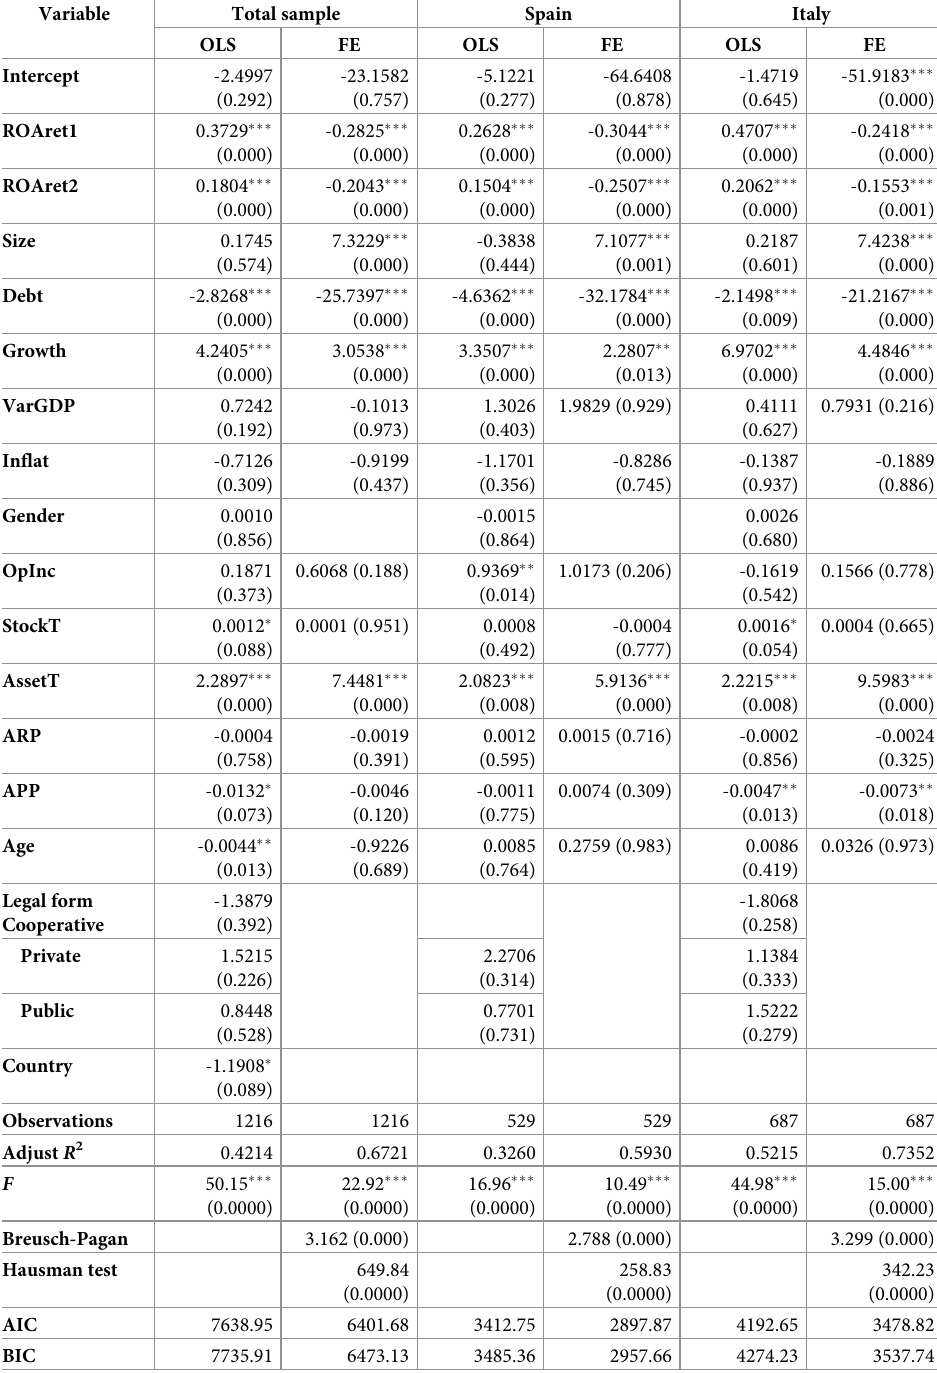
Table 7. ROA regression